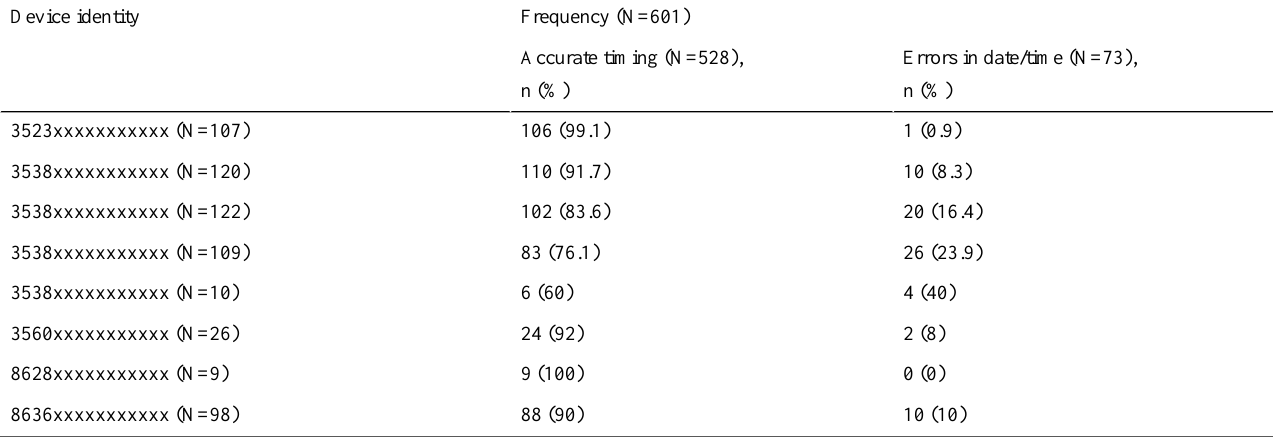
Table 3. Accuracy of date and time for Android mobile phones used for data collection (N=number of households where data were collected).